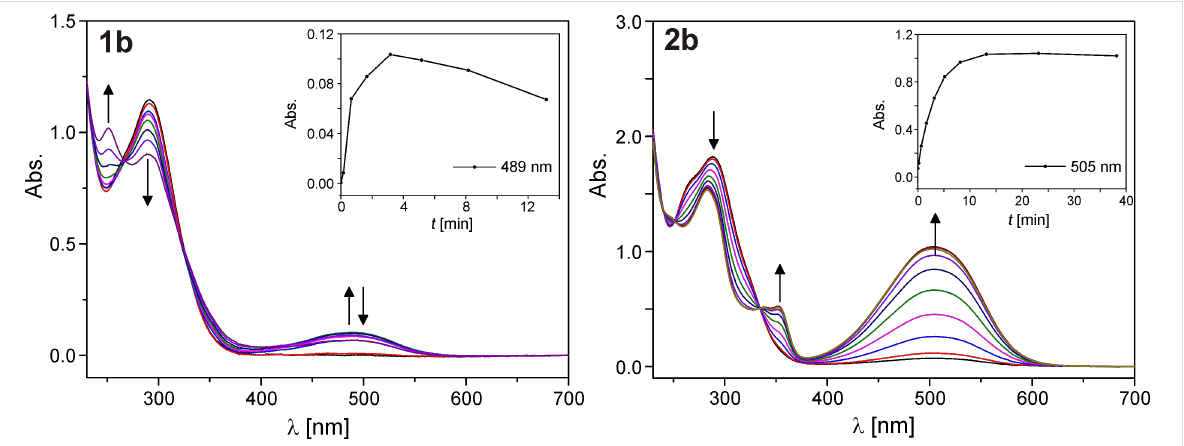
Figure 2: Spectral changes of the pyridyl switch with one ( 1b ) and two ( 2b ) methyl groups upon irradiation with UV light. A 60 µM solution of the com- pound in acetonitrile was irradiated for the indicated time intervals (see inset) with UV light (366 nm) and after each interval a UV–vis absorption spec- trum was